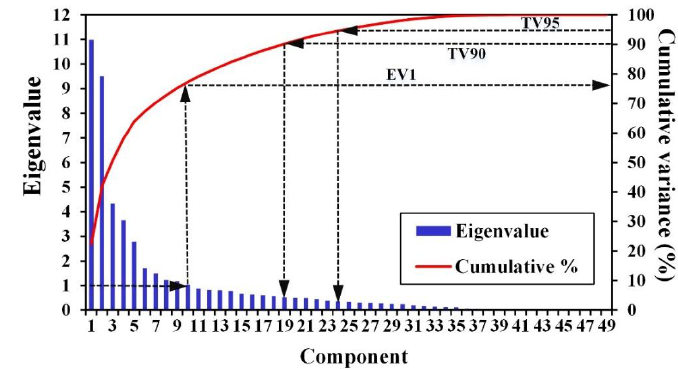
Figure 3. Eigenvalue and total variance explained for 1-h ahead wave-height predictions.